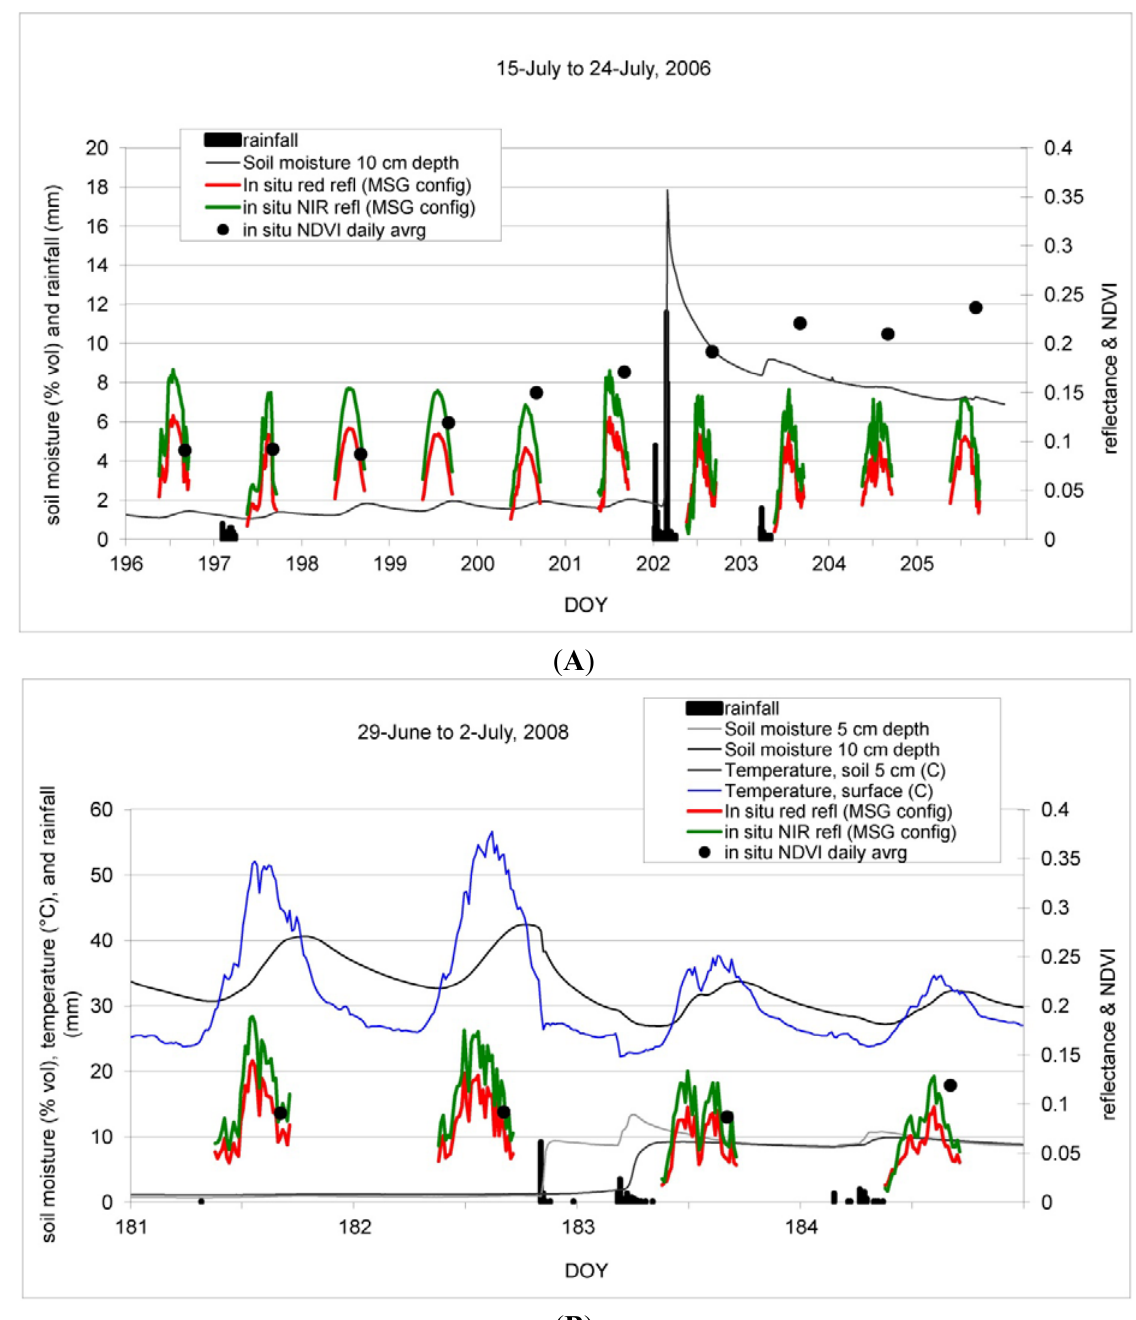
Figure 2. ( A ) Bare soil in situ data from Dahra test site, 2006. Rainfall events are shown together with Soil Moisture Content (SMC) (vol.%) at 10 cm depth, Red (red line) and Near Infrared (NIR) (green line) reflectance from 9:00 to 17:00; ( B ) Bare soil in situ data from Dahra test site, 2008. Rainfall events are shown together with SMC (vol.%) at 10 cm depth, Red (red line) and NIR (green line) reflectance from 9:00 to 17:00. In addition to Figure 2(A) land surface and soil temperatures are also